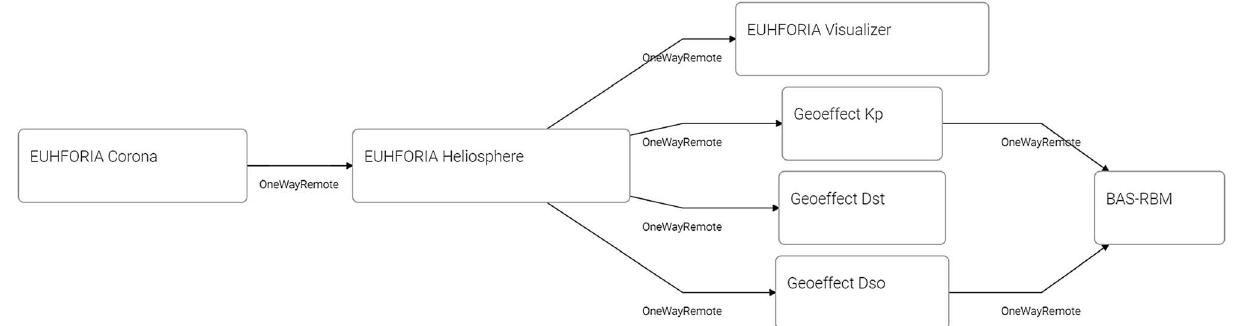
Fig. 12. The BAS-RBM model in a model chain such that it can be fed with synthetic Kp and magnetopause stand-off distance data obtained from solar wind parameters calculated